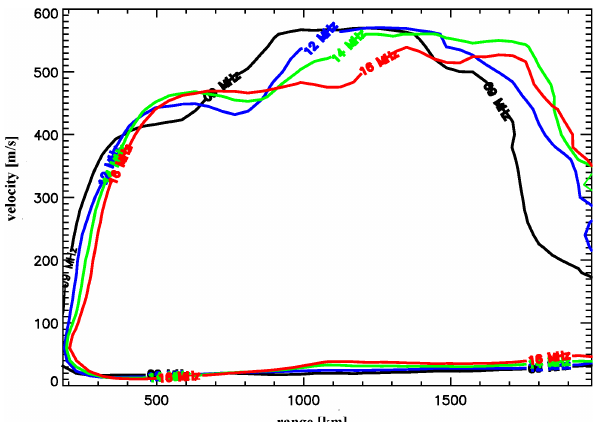
Fig. 7. Results of the simulations for the 2046-orbit extract of Fig. 1 and for a radar frequency of 9MHz (black), 12MHz (blue), 14MHz (green) and 16MHz (red) and a plasma frequency equal to 6MHz (bottom right). Results are given in units of spectral width (m.s − 1 ) as a function of the propagation